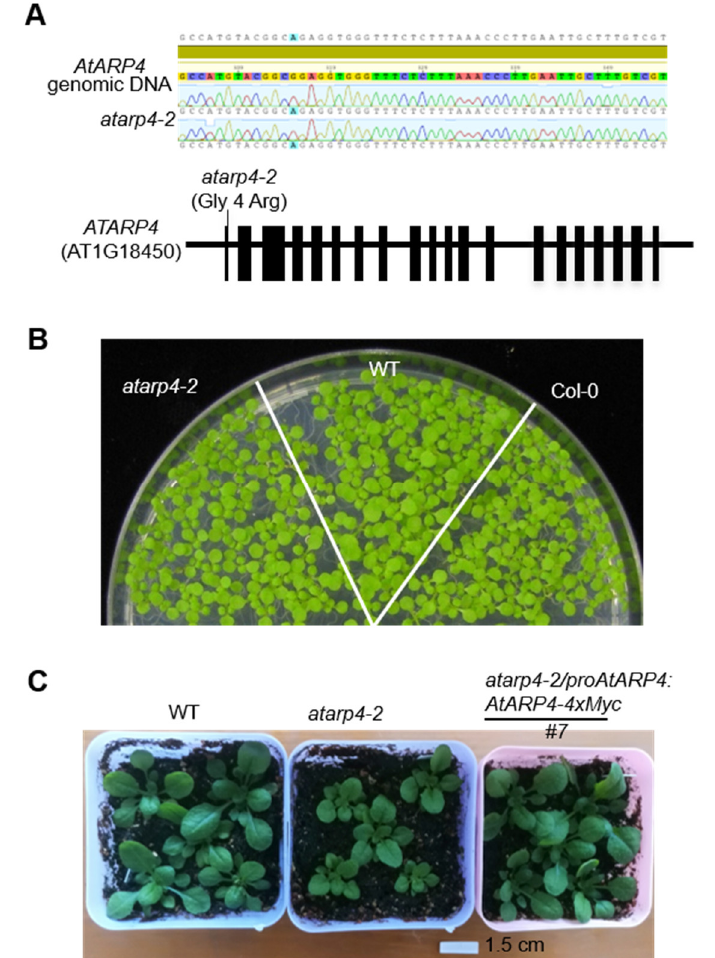
Figure 1. The identification and growth phenotypes of atarp4-2 mutant allele. ( A ) Sequence chromatograms shows the mononucleotide variation in the AtARP4 gene (upper panel) and the diagram for AtARP4 displays the precise mutation site and nucleotide substitution (lower panel). The red, black and green boxes indicate the exons, introns, and untranslated regions (UTR), respectively. ( B ) Germination test for atarp4-2 , wild type (WT), and Col-0. Representative image for 7-day-old seedlings grown on 1/2 MS medium supplemented with 1% glucose. The transgenic plants with expressing cauliflower mosaic virus 35S promoter-driven sucrose transporter 2 ( 35S:SUC2 ) were referred as WT. The atarp4-2 mutant was screened from the 35S:SUC2 background. ( C ) Soil-based growth phenotypes of atarp4-2 and its complementation line with the AtARP4 native promoter . Representative images for 5-week-old plants are shown. Western blotting was performed to detect atarp4-2/proAtARP4:AtARP4-4xMyc transgenic lines using anti-Myc antibody (Figure S1). Unsegregated T3 plants were identified as homozygous complementation lines and were then used for the growth phenotype detection experiment.